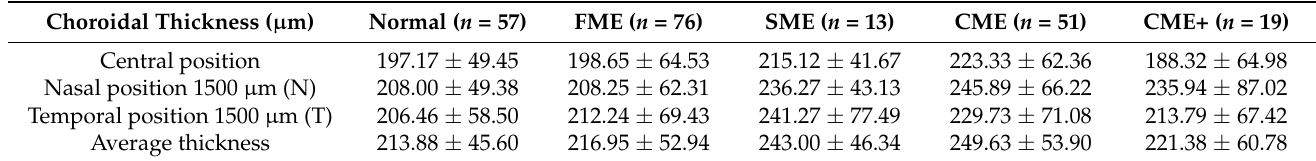
Table 4. Comparison of choroidal thickness measurements (using the automated method) between normal and focal macular edema (FME), spongy macular edema (SME), cystic macular edema (CME), and CME with subretinal edema